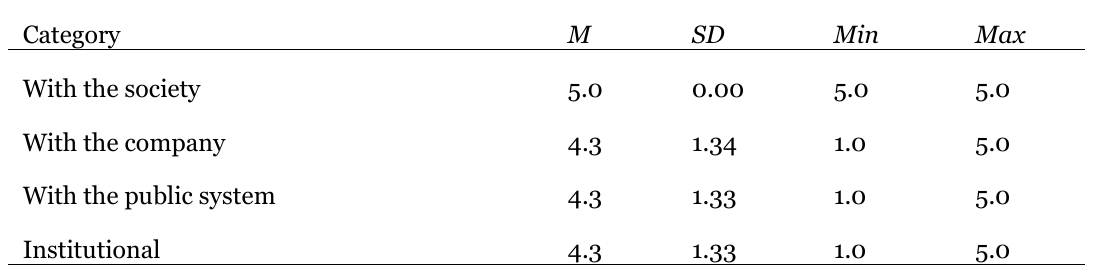
Entailment Dimension’s Results